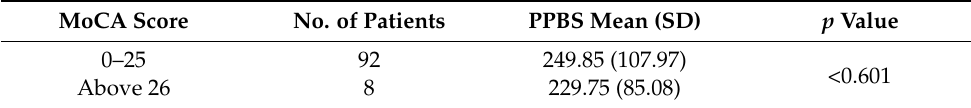
Table 4. Correlation of the MoCA score with PPBS in the test group.